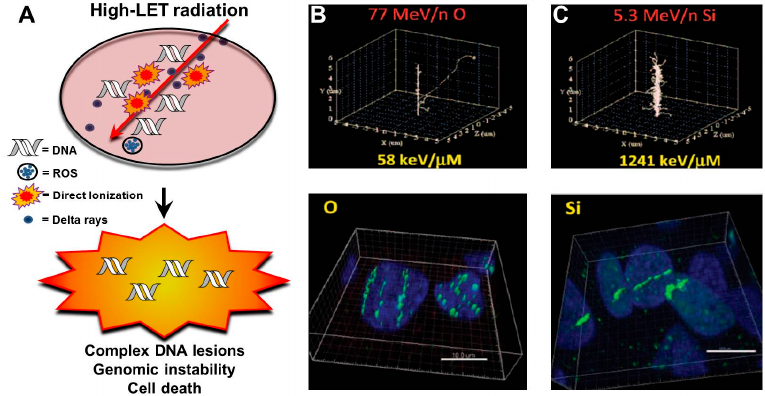
Figure 2. ( A ) High- linear energy transfer (LET) radiation-induced DNA damage consists of clustered lesions which eventually promote genomic instability and, if DNA repair is not successful, cell death. ( B and C ) Simulated particle track projections of oxygen ( B , upper panel) and silicon ( C , upper panel) beams. Immunofluorescence staining for the DNA damage protein γ -H2AX showing track structures in human fibroblasts after oxygen ( B , lower panel) and silicon ( C , lower panel) beams. (Permission was granted to adapt and re-publish these images from Sridharan et al. “Understanding Cancer Development Processes after HZE-Particle Exposure: Roles of ROS, DNA Damage Repair and Inflammation” Radiat Res 2015; 183:1–26 and from Saha et al. “Biological Characterization of the Low-Energy Ions with High-Energy Deposition on Human Cells” Radiat Res 2014; 182:282–291). ROS: reactive oxygen species.